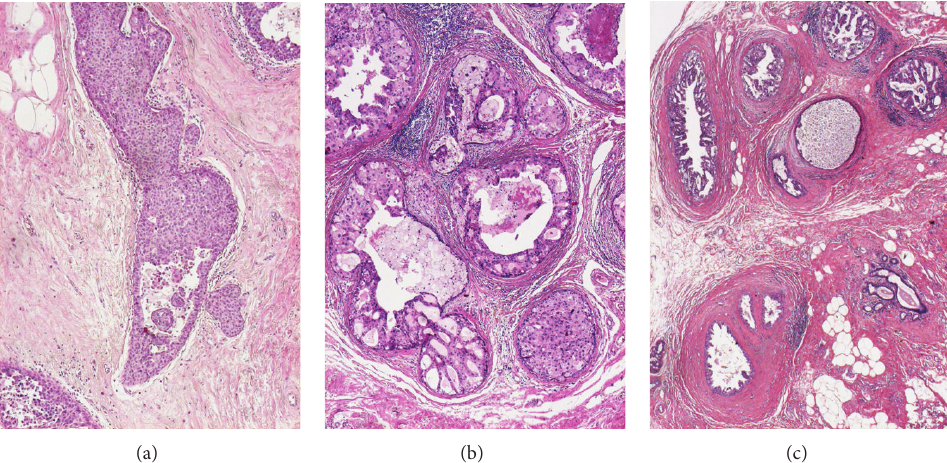
Figure 3: Fibrosis-like thickening of the periductal stroma. Hematoxylin-eosin stain; microscopic magnification 60 × . (a) No periductal fibrosis; (b) little periductal fibrosis; (c) much periductal fibrosis.